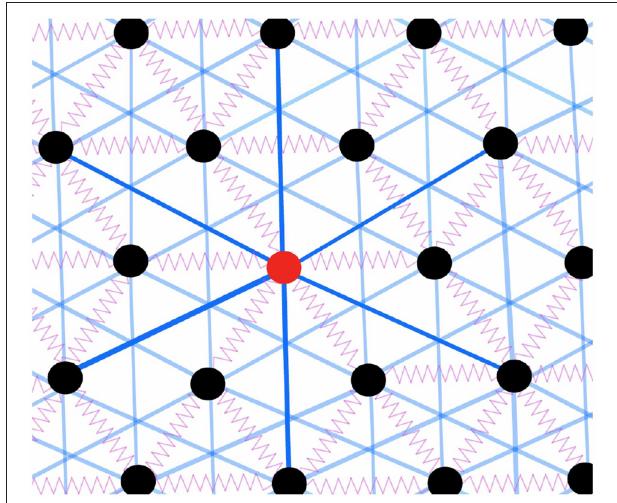
FIGURE 1 | Sketch of the model. The black circles represent the particles, the purple springs represent the strong interaction between nearest neighbors while the blue lines represent the VdW interactions between next nearest neighbors. We color one of the particles in red with bold blue lines for illustration